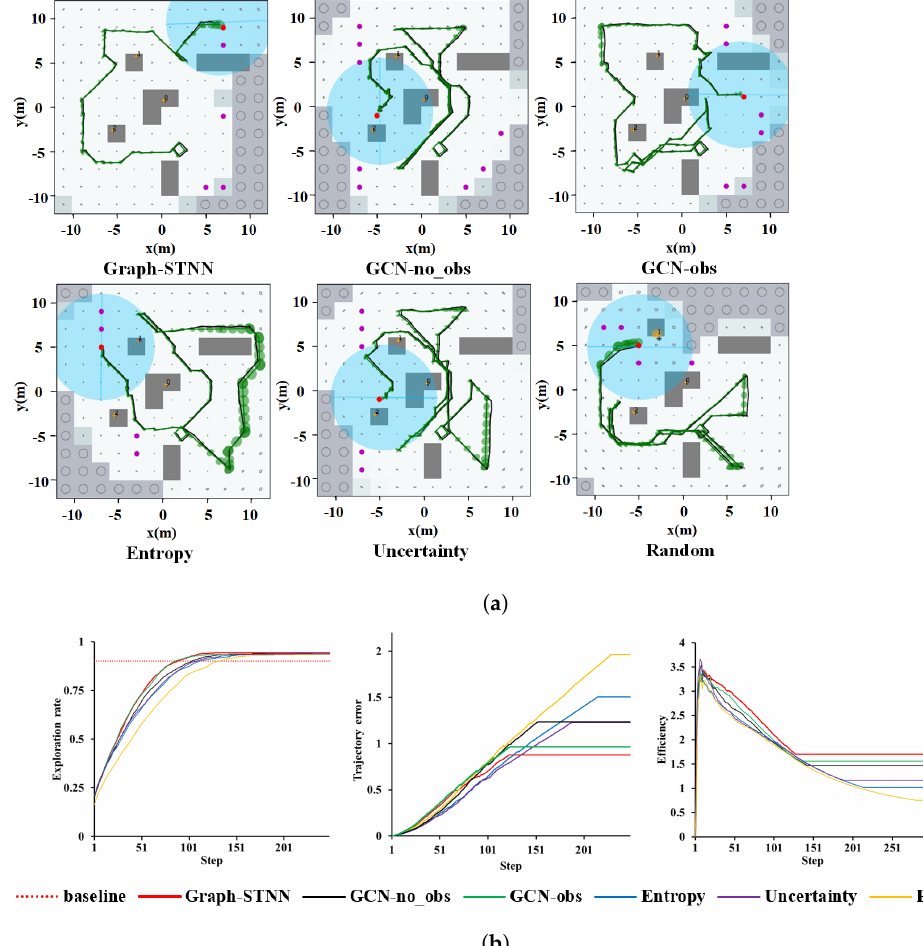
Figure 10. The results of 50 exploration trials of Graph-STNN, GCN-obs, GCN-no_obs, entropy- based, uncertainty-based and random methods , with the same randomly initialized landmarks and robot start locations, on 20 m × 20 m maps. ( a ) One of the test result of 50 exploration trials. ( b ) Average exploration rate (left), trajectory error (middle), and exploration efficiency